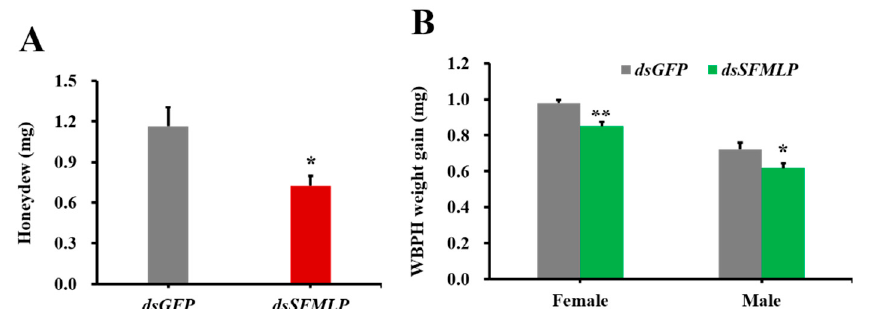
Figure 2. Effects of SFMLP silencing on WBPH performance. ( A ) The excreted honeydew of WBPH after injection of dsRNA ; ( B ) the body weight gains of newly emerged WBPH females and males injected with dsRNA . dsGFP indicates WBPH injected with GFP - dsRNA ; dsSFMLP indicates WBPH injected with SFMLP - dsRNA . * and ** indicate statistically significant differences ( t- test: p < 0.05 and p < 0.01). Bars, ±SEM.